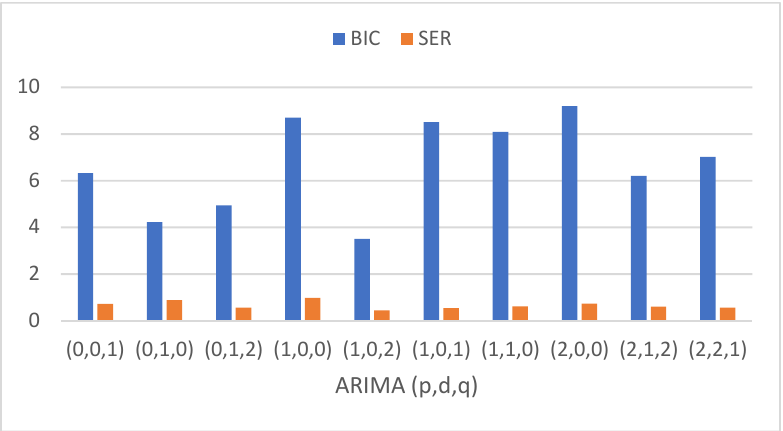
Figure 5. ARIMA parameters (p, d, q) selection based on BIC and SER.